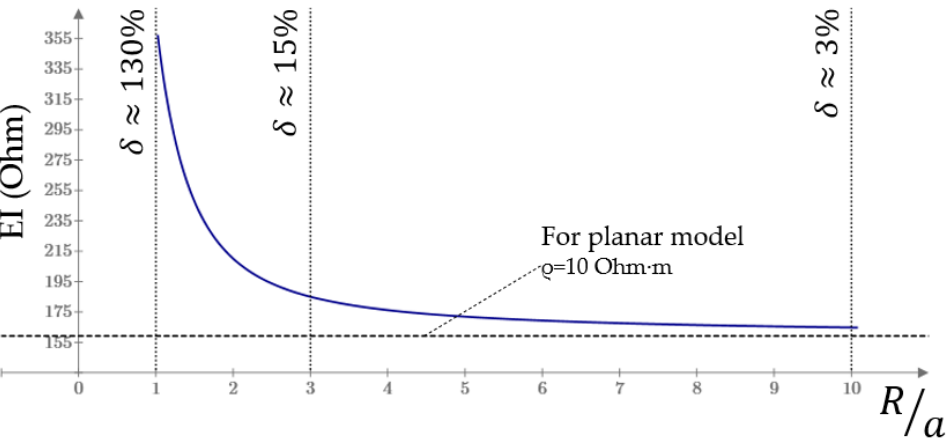
Figure A4. Simplification of the homogeneous cylindrical model to a planar one (R is the cylindrical model radius; a is the interelectrode distance).